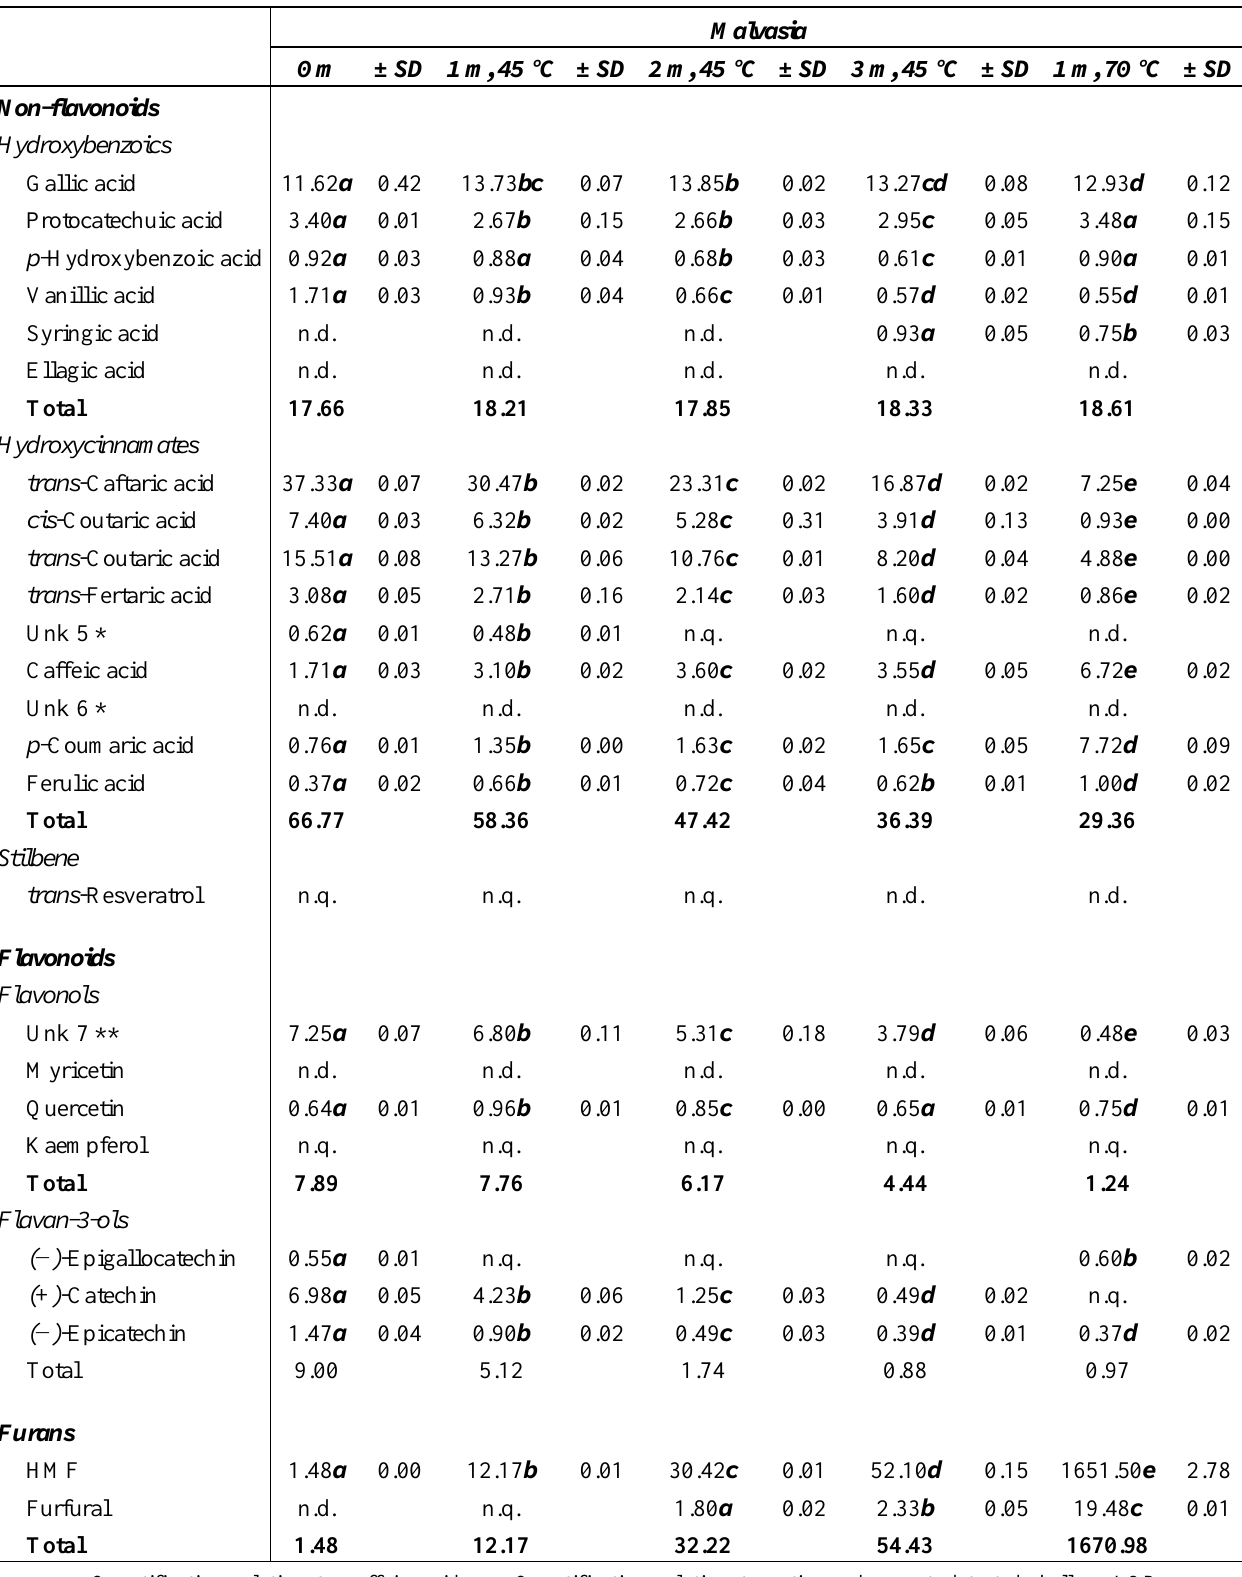
Table 4. Individual polyphenols and furans (mg/L) in Malvasia wine during heating at 45 °C (3 months) and 70 °C (1